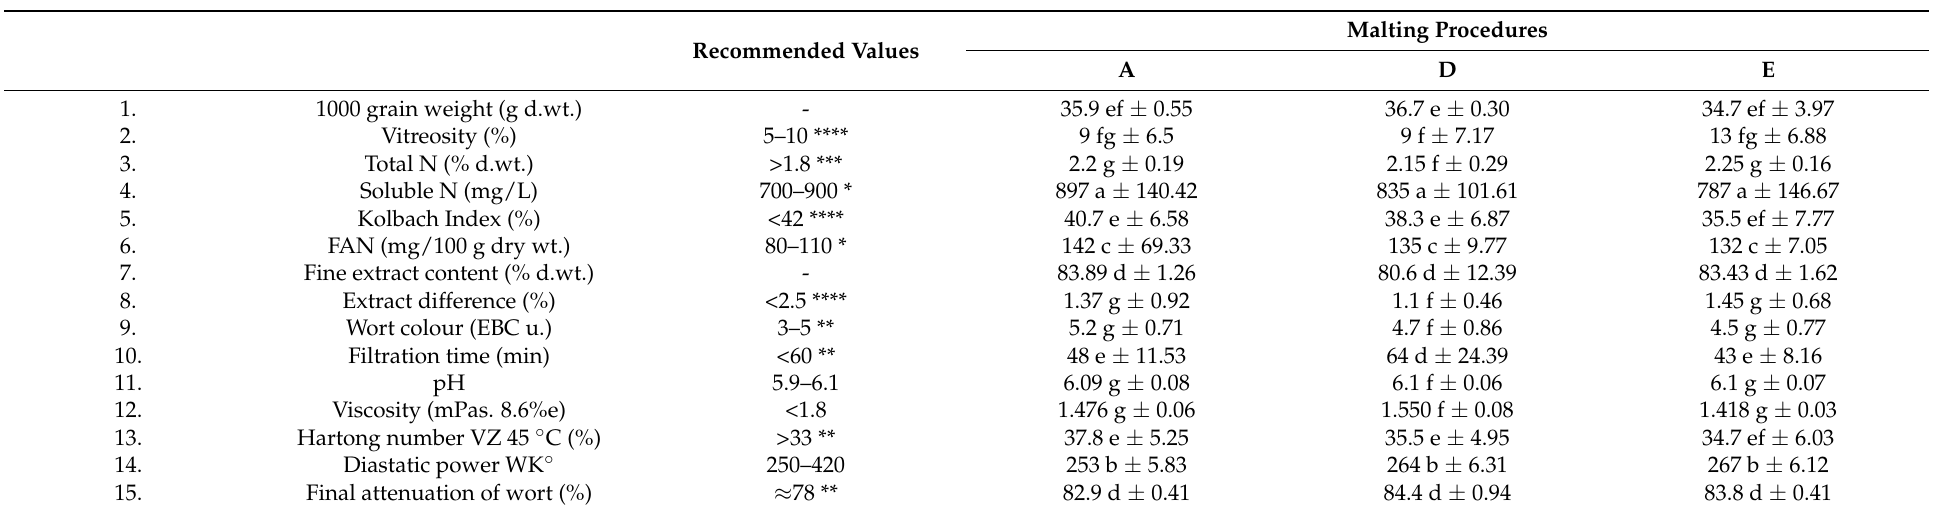
Table 8. Mean values of the testing varieties for the quality parameters of wheat malt.